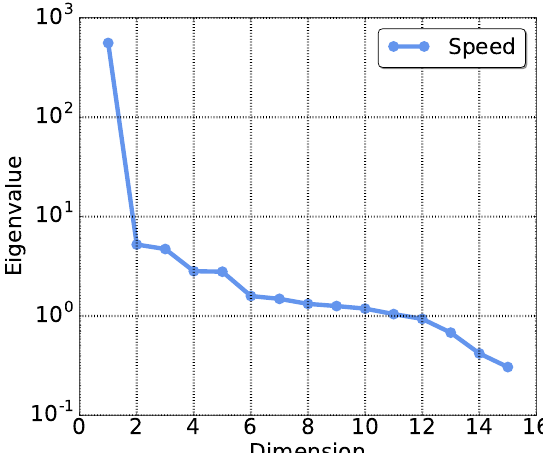
Figure 4. Eigenvalues for different dimensions.